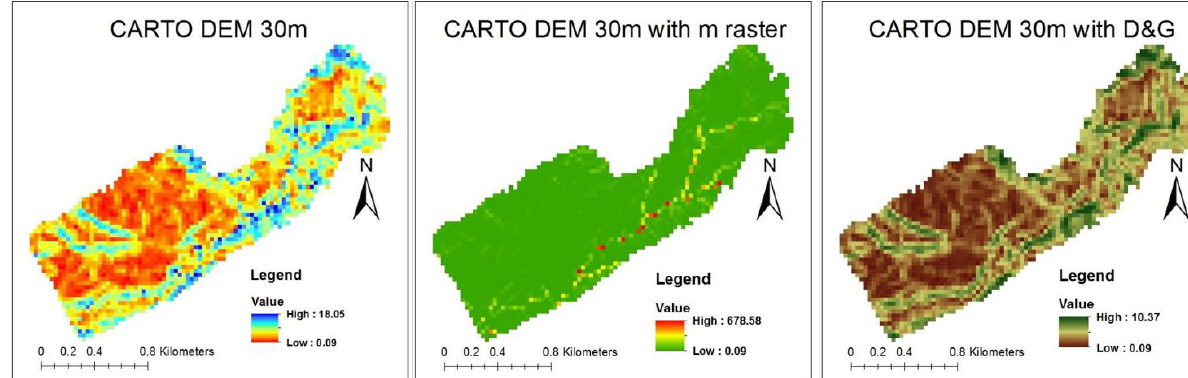
Figure 6: LS factor of CARTO DEM 30m with constant slope exponent, spatially distributed slope exponent and with multiple